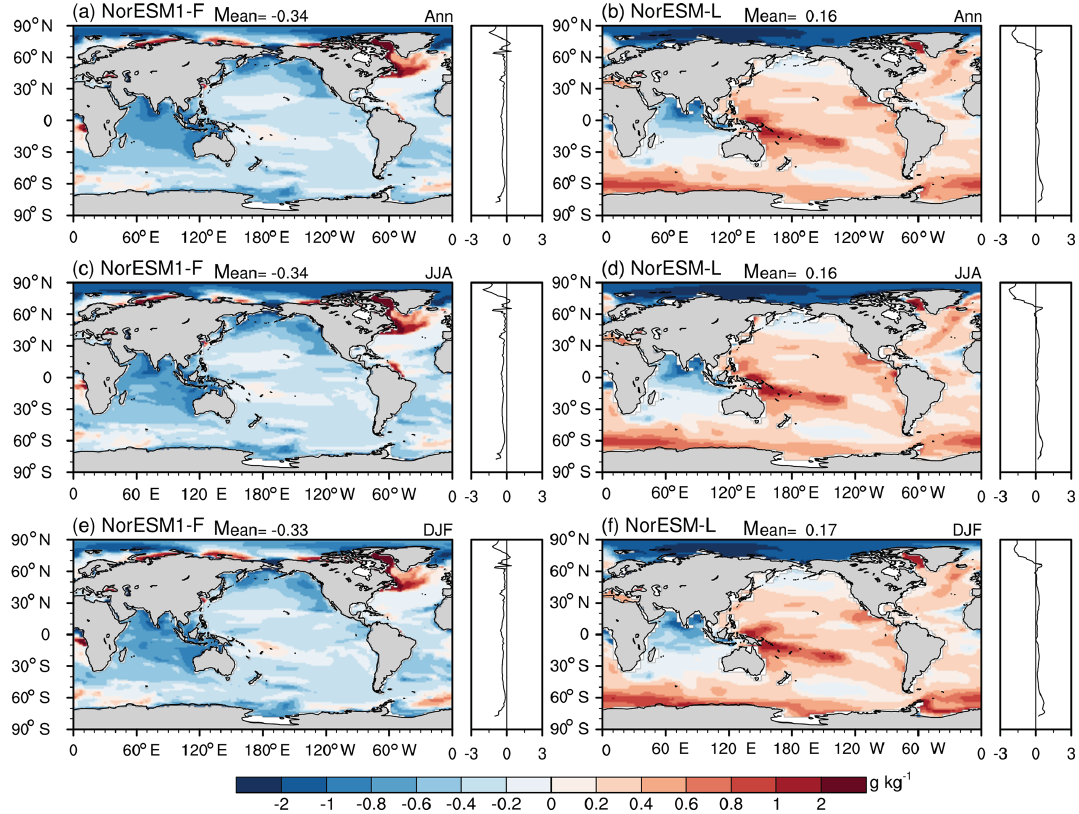
Figure 4. Same as Fig. 1 but for sea surface salinity (units: gkg − 1